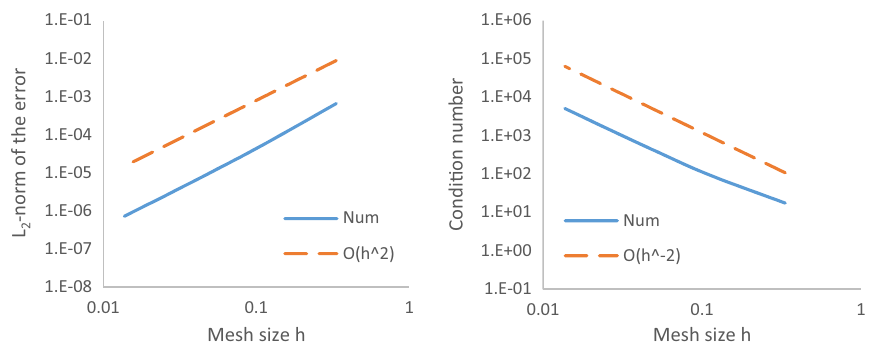
Fig. 12 Plot of the L 2 -norm of the error and 2-norm condition number